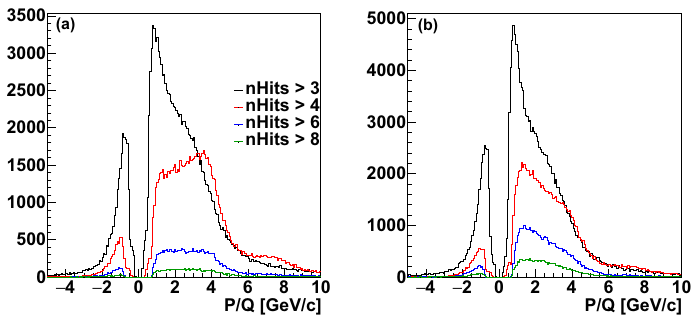
Figure 5. Momentum spectra of reconstructed charged particles for carbon (a) and lead (b) targets as a function of number of hits per